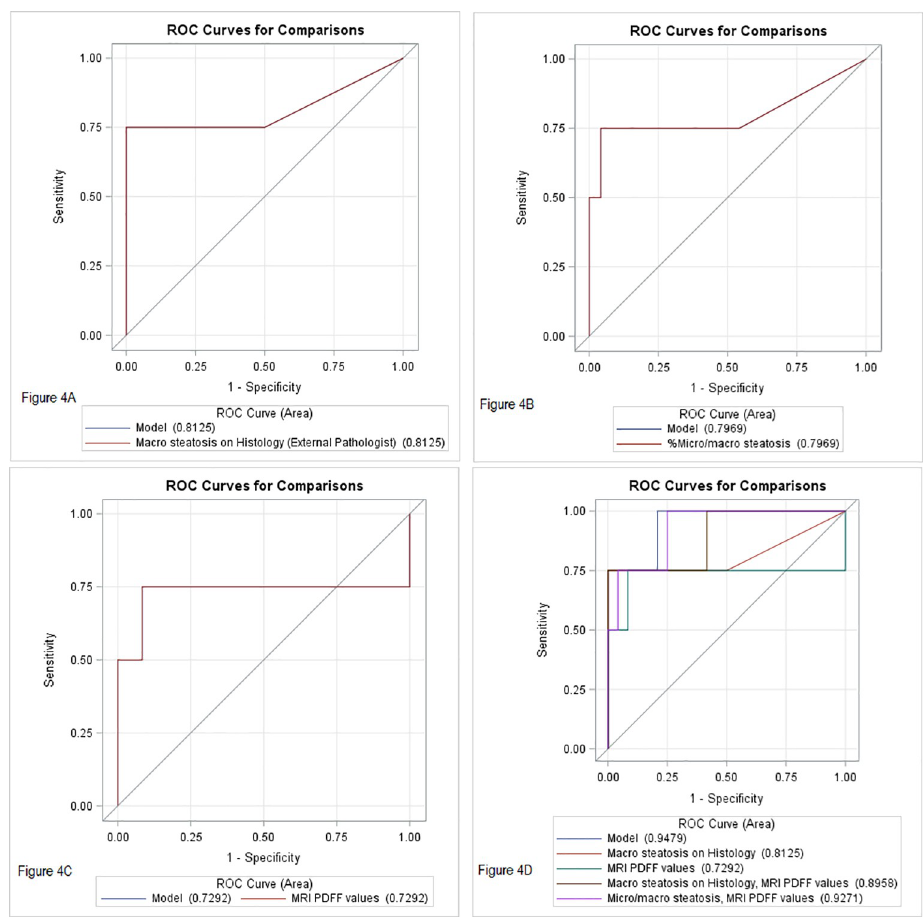
Fig 5. Comparison of area under ROC curves in predicting peak bilirubin > 10 mg/dl. Results are compared for hepatic steatosis quantification based on histology (External Pathologist -read out) and MRI PDFF measurements.